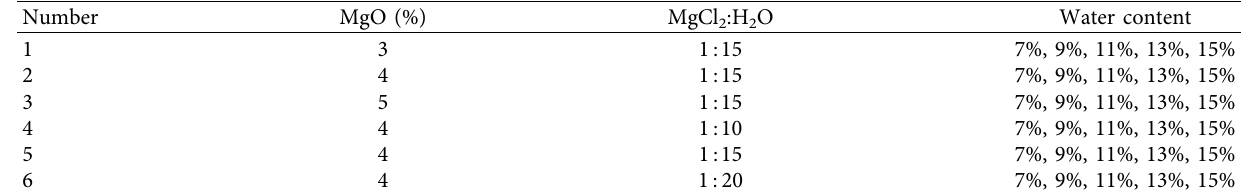
Figure 2: Test flow chart. Table 3: Compaction test ratios.